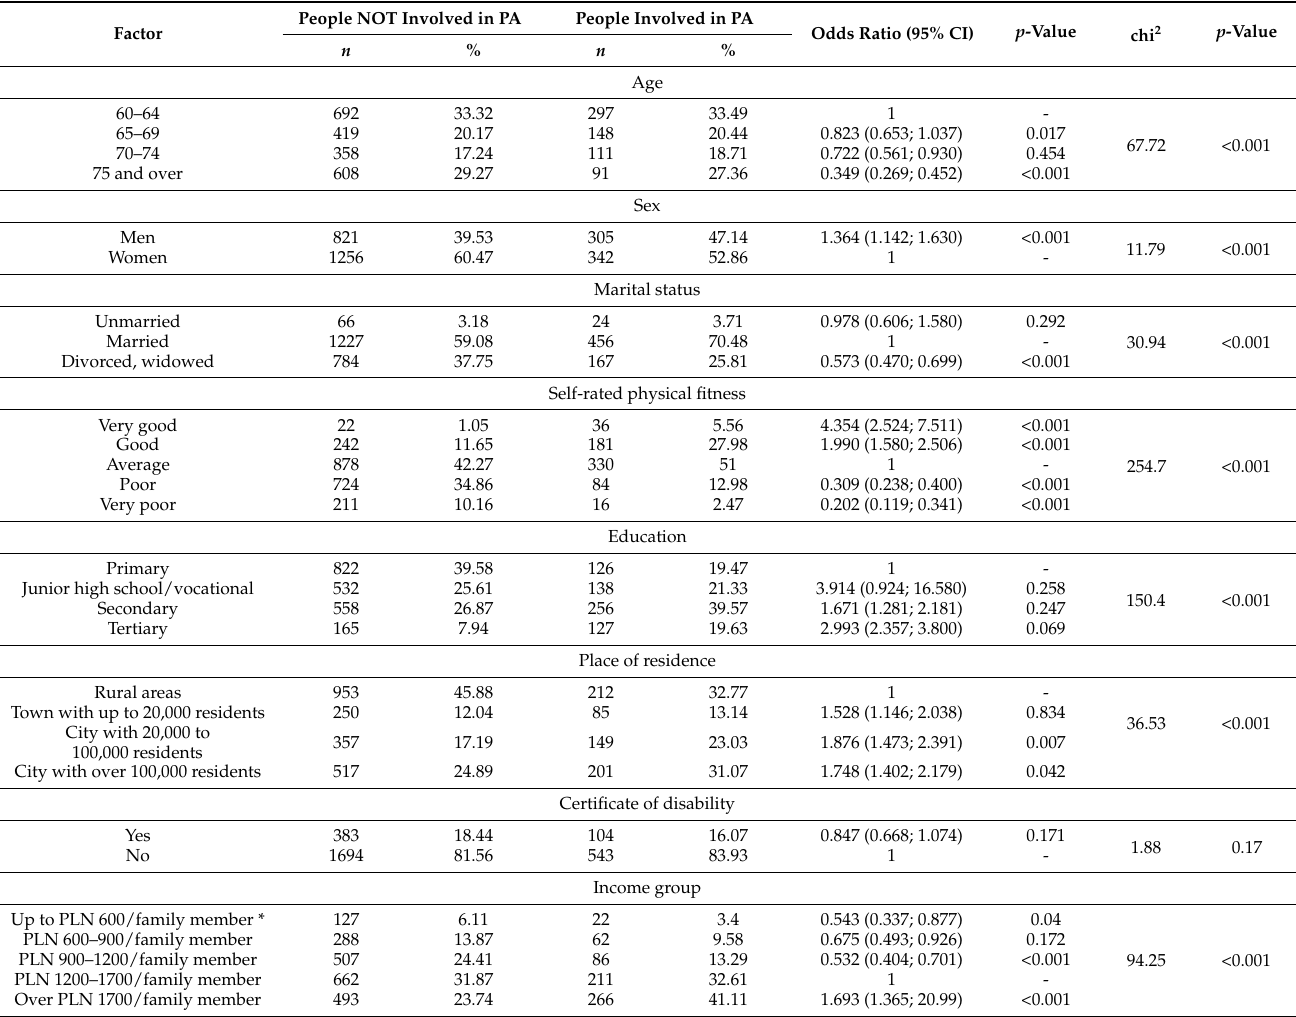
Table 1. Odds ratios (OR) at 95% confidence interval (95% CI) and chi 2 for factors determining practicing different forms of physical activity (PA) at least once or more often during the year before the survey in the Polish